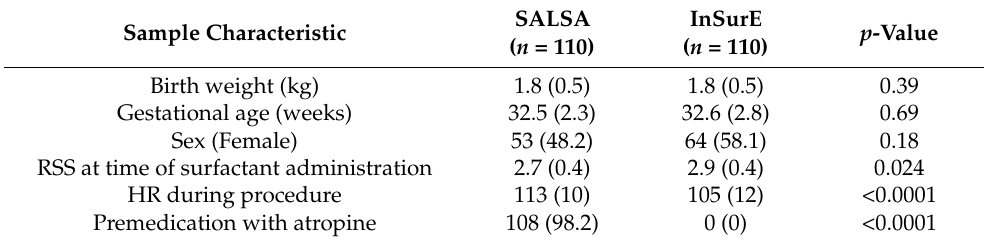
Table 1. Characteristics of the Study Cohorts †.